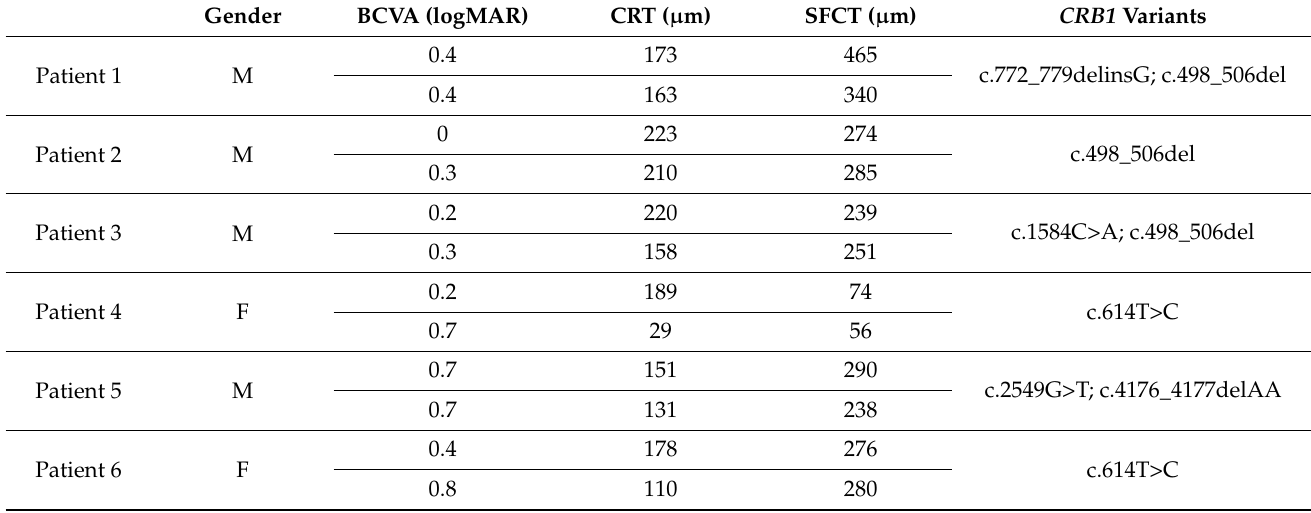
Table 1. Clinical and imaging characteristics of patients affected by CRB1 -associated retinal dystrophies.